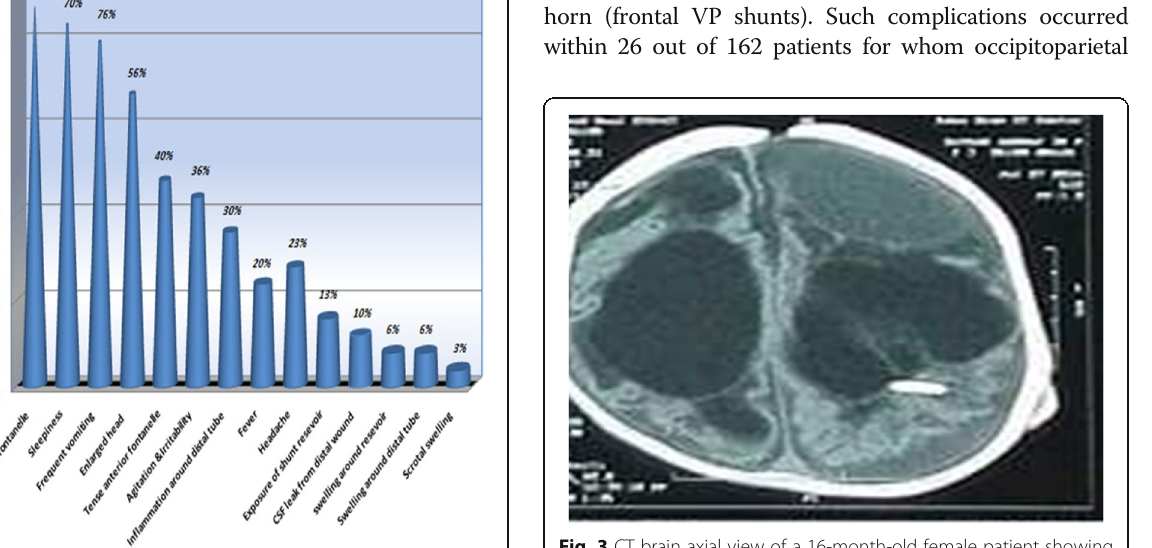
Fig. 3 CT brain axial view of a 16-month-old female patient showing left-sided VP shunt causing picture of